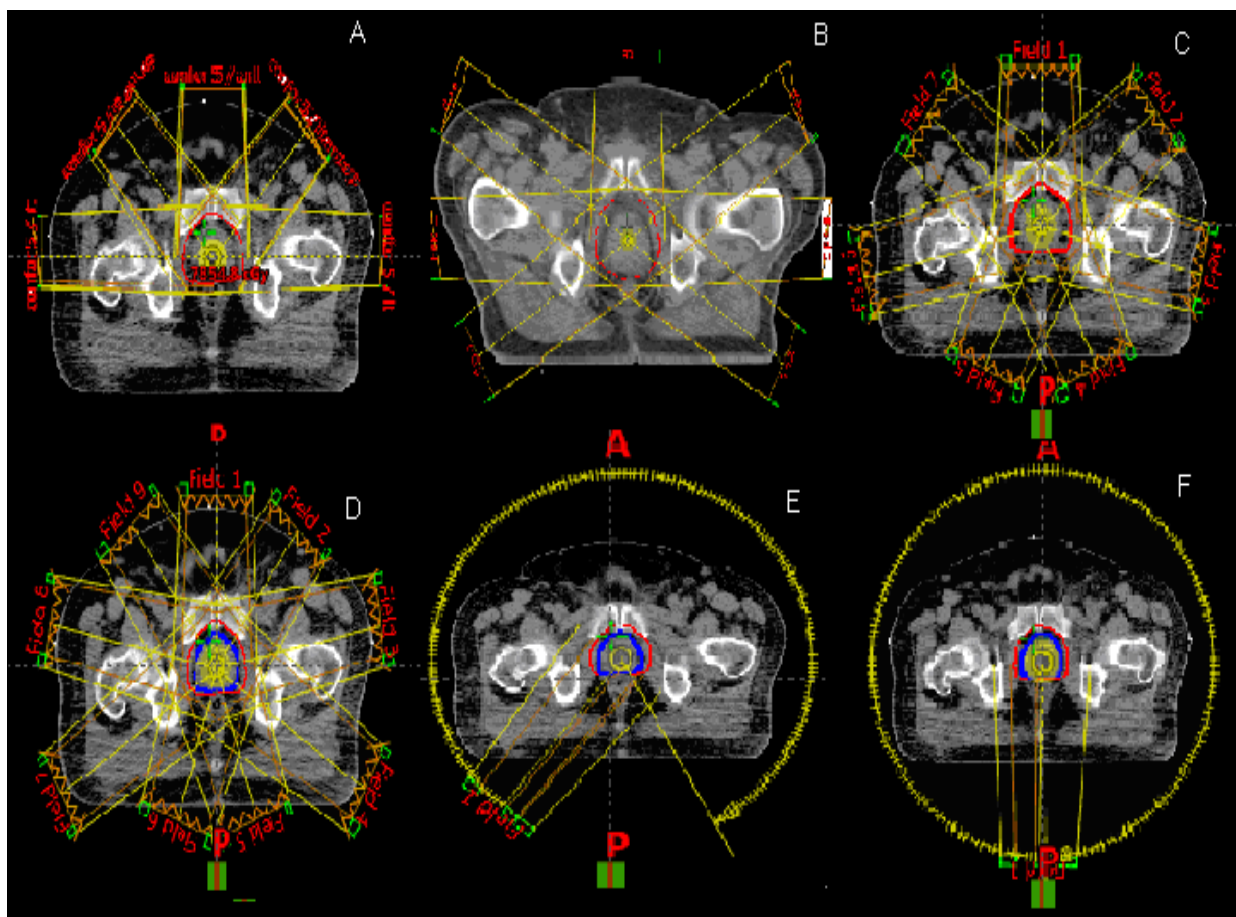
Figure 1: Beam arrangement for six plans. A : 3DCRT with five fields (3DCRT-5); B : 3DCRT with seven fields (3DCRT- 7); C : IMRT with seven fields (IMRT-7); D : IMRT with nine fields (IMRT-9); E : Single arc with 300 0 arc angle (RapidArc-rectum); F : A single full arc